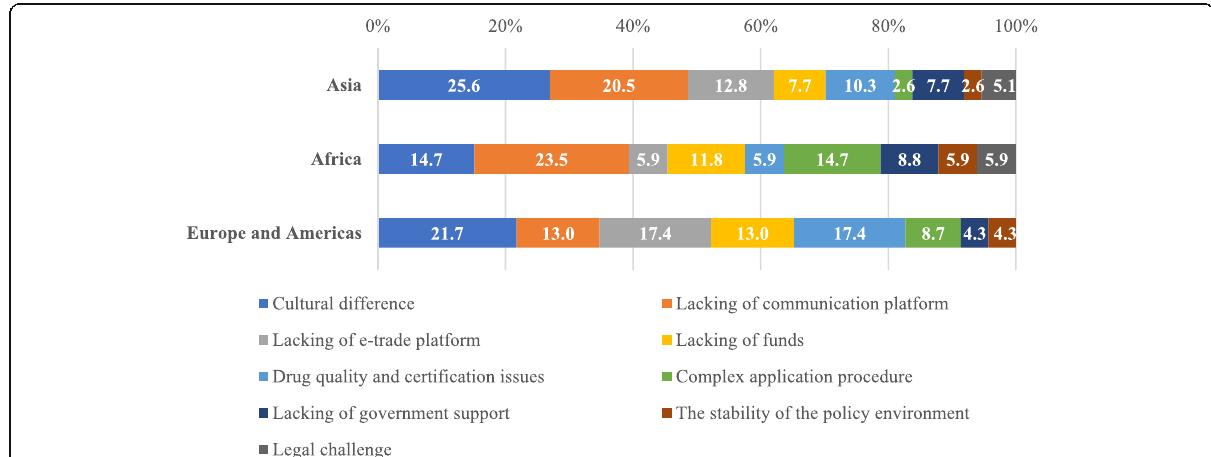
Fig. 3 Barriers perceived by respondents from Asia (n = 24), Africa (n = 19), Europe and the Americas (n = 15) on their countries ‘ participation in